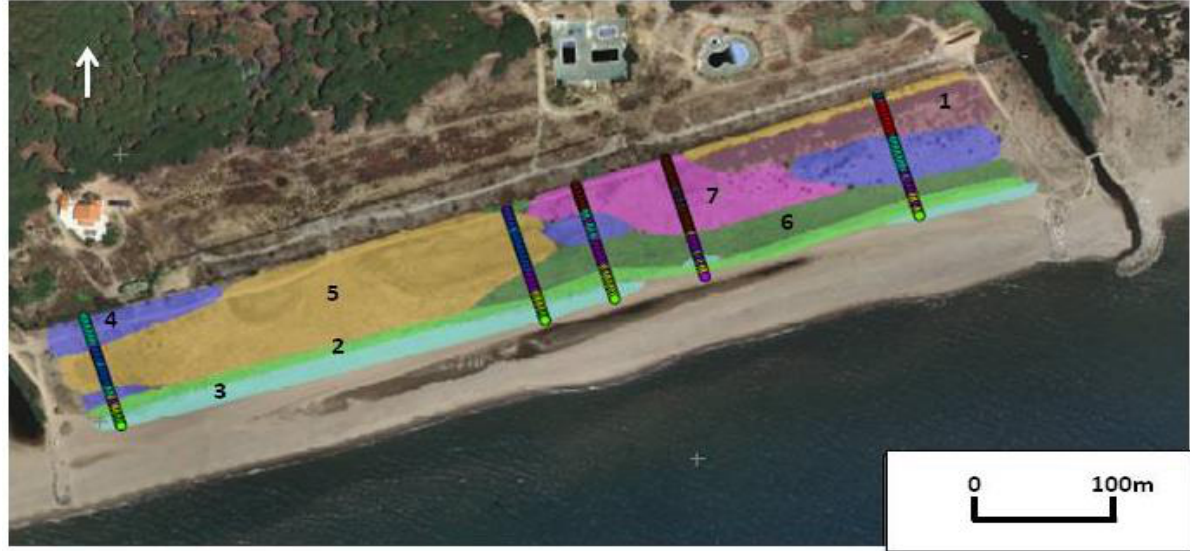
Figure 7. Map of the surface distribution of plant communities in 2013. The numbers represent the distinct communities differentiated in Table 2, and the colors the distribution of the communities. (1) Pine forest; (2) primary dune vegetation; (3) embryonic dunes vegetation; (4) secondary dune vegetation; (5) opportunistic and ruderal vegetation ( Cakilion maritimae alliance with Cyperus capitatus ); (6) psammophilous vegetation of interdune depressions; (7) ruderal vegetation ( Cakilion maritimae alliance with Ambrosia coronopifolia ). The distribution of the different communities clearly shows the arrangement in longitudinal bands parallel to the coastline of the primary dune (2) and embryonic dune (3) communities. The zones most affected by human trampling show communities of the opportunistic (5) and ruderal (7) type, which interrupt the distribution of the secondary dune (4) and inter-dune depression (7)